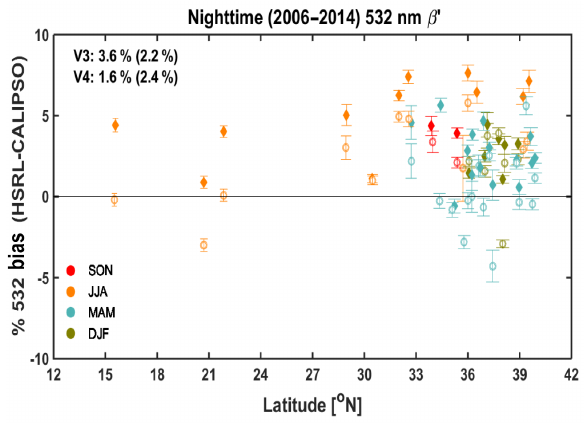
Figure 17. Difference between HSRL and CALIOP attenuated backscatter measurements for nighttime clear-air profiles as a func- tion of latitude. The data are colored by the season of measurement. V3 differences are shown as filled diamonds, and the corresponding V4 differences are shown as open circles. The error bars for each point represent the SD of the